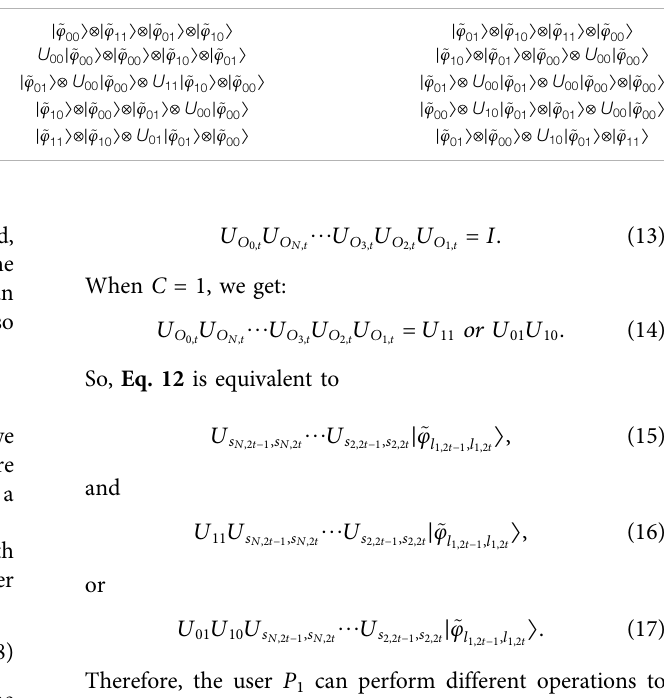
TABLE 2 | Change of the particle sequences during the encoding phase of the three-user protocol. P